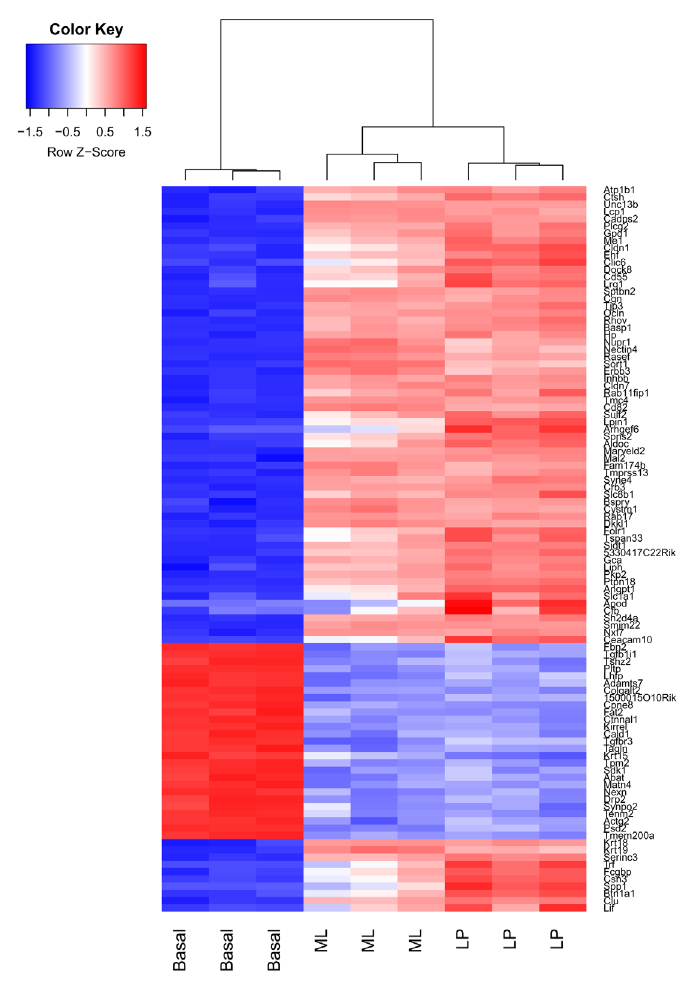
Figure 7. Heatmap of log-CPM values for top 100 genes DE in basal versus LP. Expression across each gene (or row) have been scaled so that mean expression is zero and standard deviation is one. Samples with relatively high expression of a given gene are marked in red and samples with relatively low expression are marked in blue. Lighter shades and white represent genes with intermediate expression levels. Samples and genes have been reordered by the method of hierarchical clustering. A dendrogram is shown for the sample